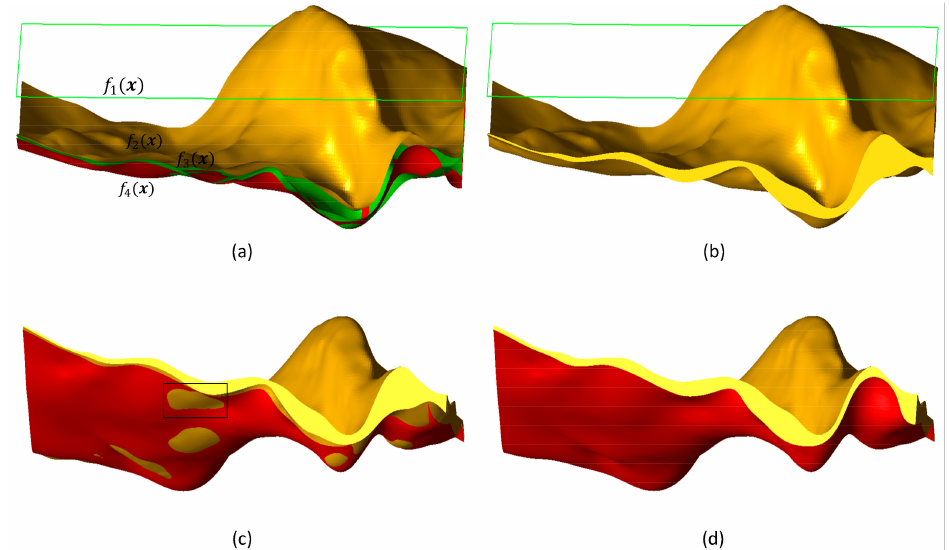
Figure 6. Combination constraint of the stratabound ore deposit: ( a ) the hanging side surface of orebody (yellow), the foot side surface of orebody (green), the geological interface (red) and the line constraints; ( b , c ) show the interpolated model without considering the geological interface; ( d ) the interpolated model with the constraint of the geological